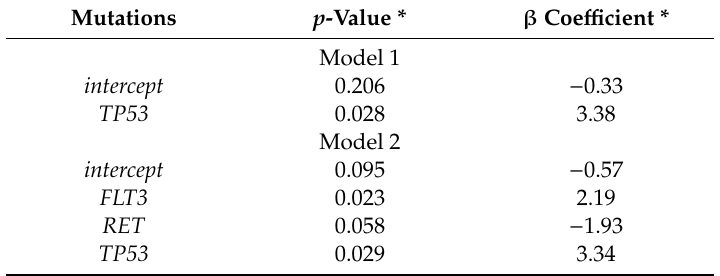
* Penalized maximum likelihood estimation method for bias correction (Firth’s